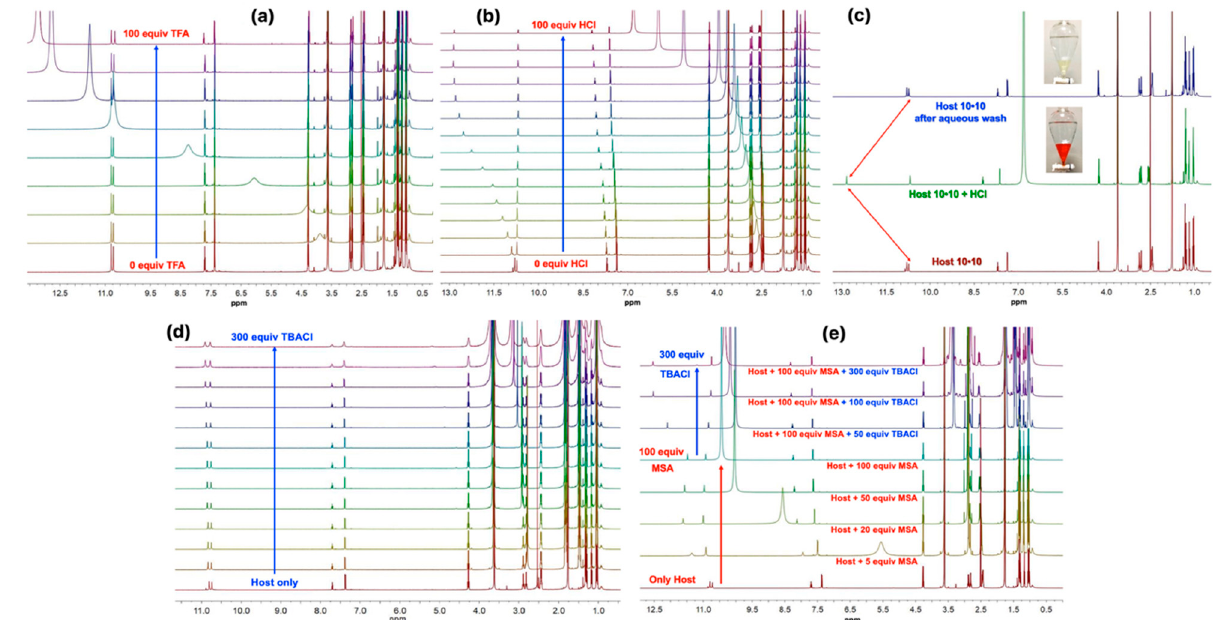
Figure 6. ( a , b ) Changes in the 1 H nuclear magnetic resonance (NMR) spectrum seen when receptor 10 was subjected to titration with increasing quantities (up to 100 equiv) of TFA and HCl in THF- d 8 at 298 K. Panel ( c ) demonstrates the reversible guest binding process of 10 with HCl through simple aqueous washing. (Note: the color of the host–guest complex changes from deep red to colorless upon aqueous wash.) ( d ) The 1 H NMR titration result with the receptor against TBACl in THF- d 8 at 298 K, showing no chemical shift, which indicates that there was no anion binding event. ( e ) Demonstration of the proton-coupled anion binding mechanism involved in the polymeric receptor against strong acids: Protonation via gradual addition of MSA, followed by incremental addition of 300 equiv of TBACl, showing the downfield chemical shift of NH proton signals, indicating an anion binding phenomenon under identical experimental conditions. All of these experiments were carried out with a 5 mM receptor 10 solution in THF- d 8 at 298